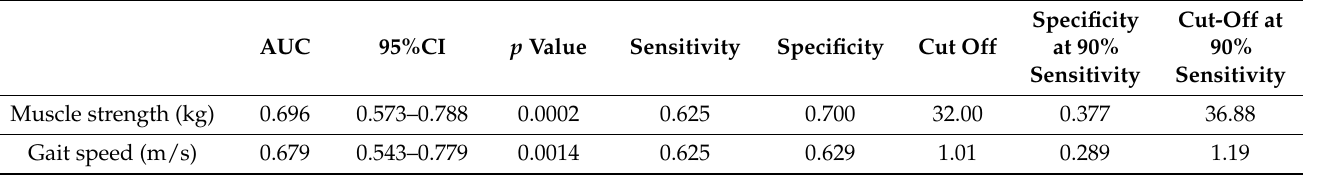
Table 2. Diagnostic performance of the handgrip strength (kg) and gait speed cut-off points to detect low SMM in the study population (n =